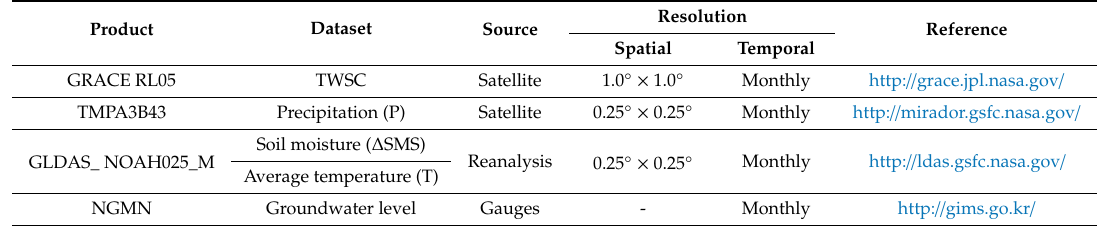
Table 1. Information of data used in this